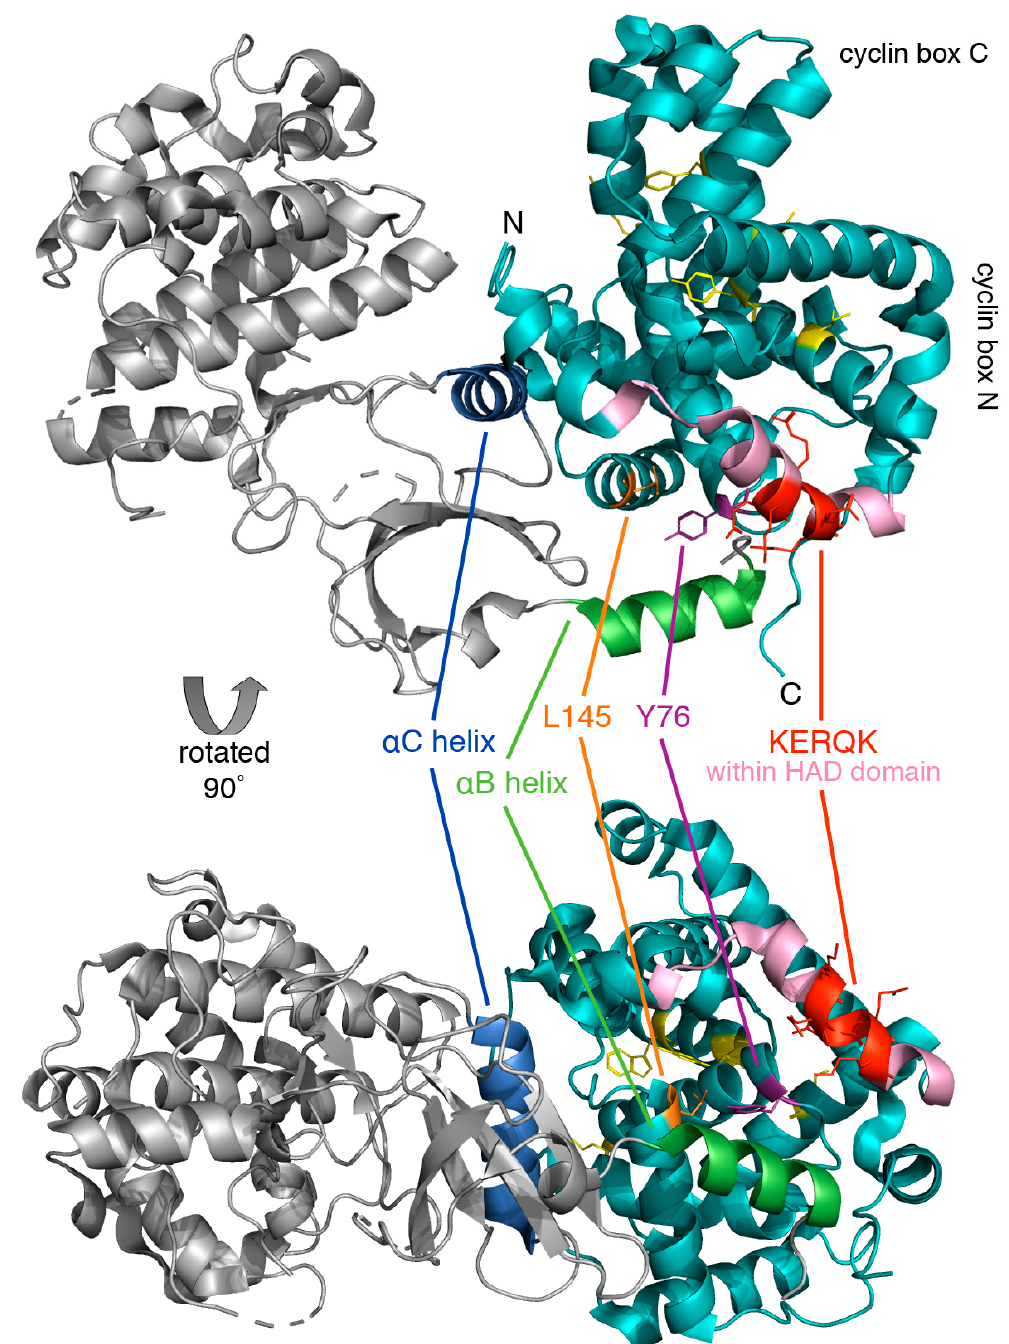
Figure 4. Crystal structure of human cyclin C-Cdk8 heterodimer. The ribbon model of cyclin C (cyan) and Cdk8 (grey) was generated using PyMol, PDB code 3RGF [48]. Highlighted is the conserved N-terminal KERQK sequence (red) within the HAD domain (pink) and two amino acid residues of cyclin C critical for establishing interaction with Cdk8, Tyr76 (Ala110 in yeast) (magenta) and Leu145 (Glu170 in yeast) (orange) [47]. The α B helix (green) and α C helix (blue) of Cdk8, which are responsible for making contact with the N-terminal cyclin box domain, and five highly conserved residues at the surface of a cyclin C-specific groove between the two cyclin folds (Ile42, Arg58, Trp177, Asp182, and Tyr184) (see Section 5.1.1) (yellow) are also indicated.